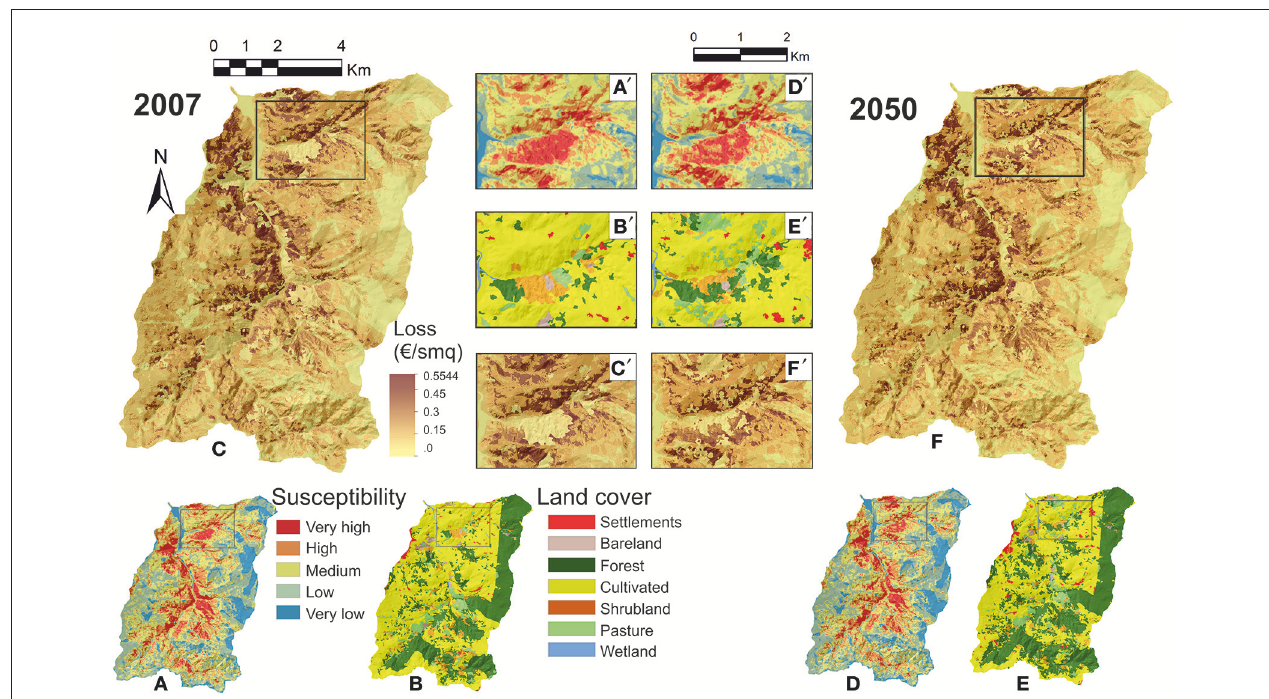
FIGURE 2 | Rivo catchment landslide susceptibility (A) , land cover (B) , and damage (C) maps for 2007 and 2050 (respectively, D–F ). In the zoomed squares (A ′ -C ′ for 2007 and D ′ -F ′ for 2050) some sectors of the related maps are highlighted.